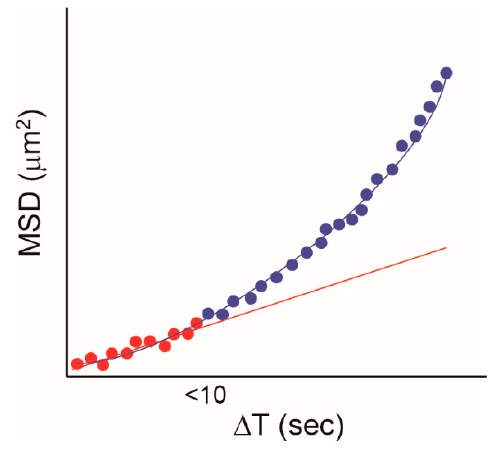
Figure 4. Simulated data showing the potential benefits of using quantum dots for SPT. Data that were only collected for the duration of fluorescence of a conventional fluorescent probe (red dots) showed a straight line fit (simple diffusion), but data that were collected for longer (blue dots) revealed an upward curve (directed motion).